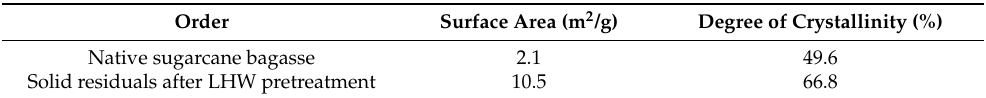
Table 3. Surface area and XRD analysis of native sugarcane bagasse and solid residue after LHW pretreatment under optimal conditions.